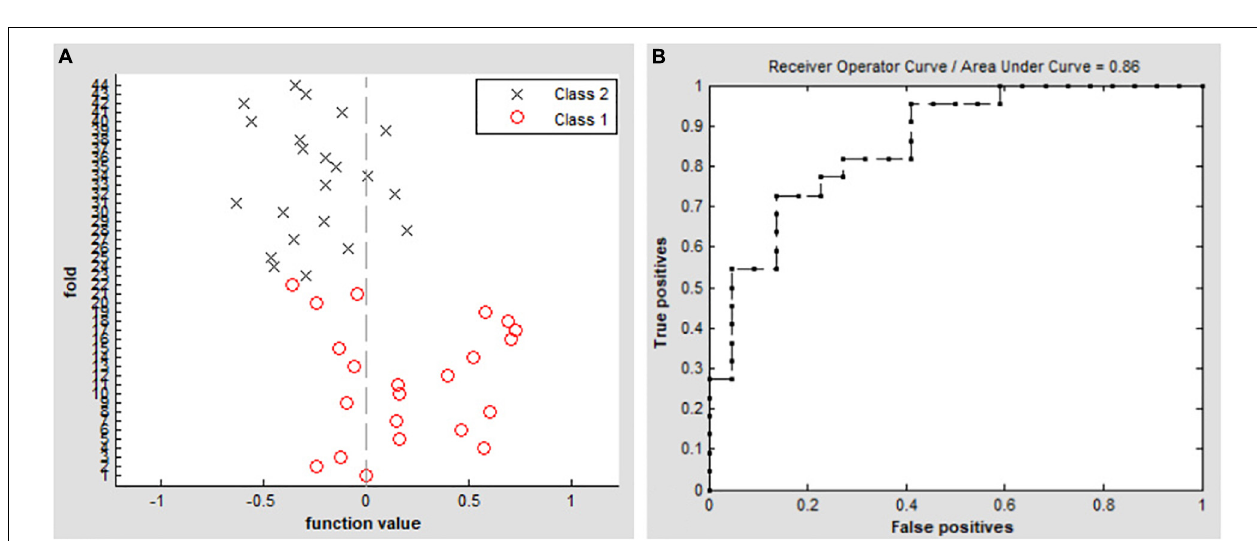
FIGURE 3 | Differences in DC values in the cerebellum between the EB and SC groups. Yellow-red denotes higher DC values and green-blue denotes lower DC values in patients with EB compared to SCs. DC, degree centrality; EB, early blindness; SCs, sighted controls; L, left; and R, right.